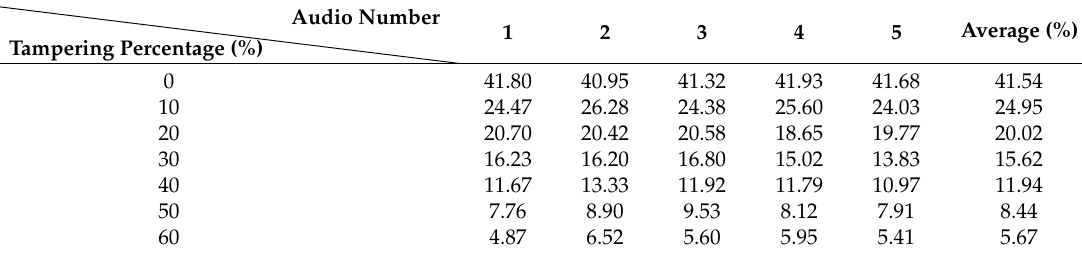
Table 4. The SNR values of all the recovered speech signal.